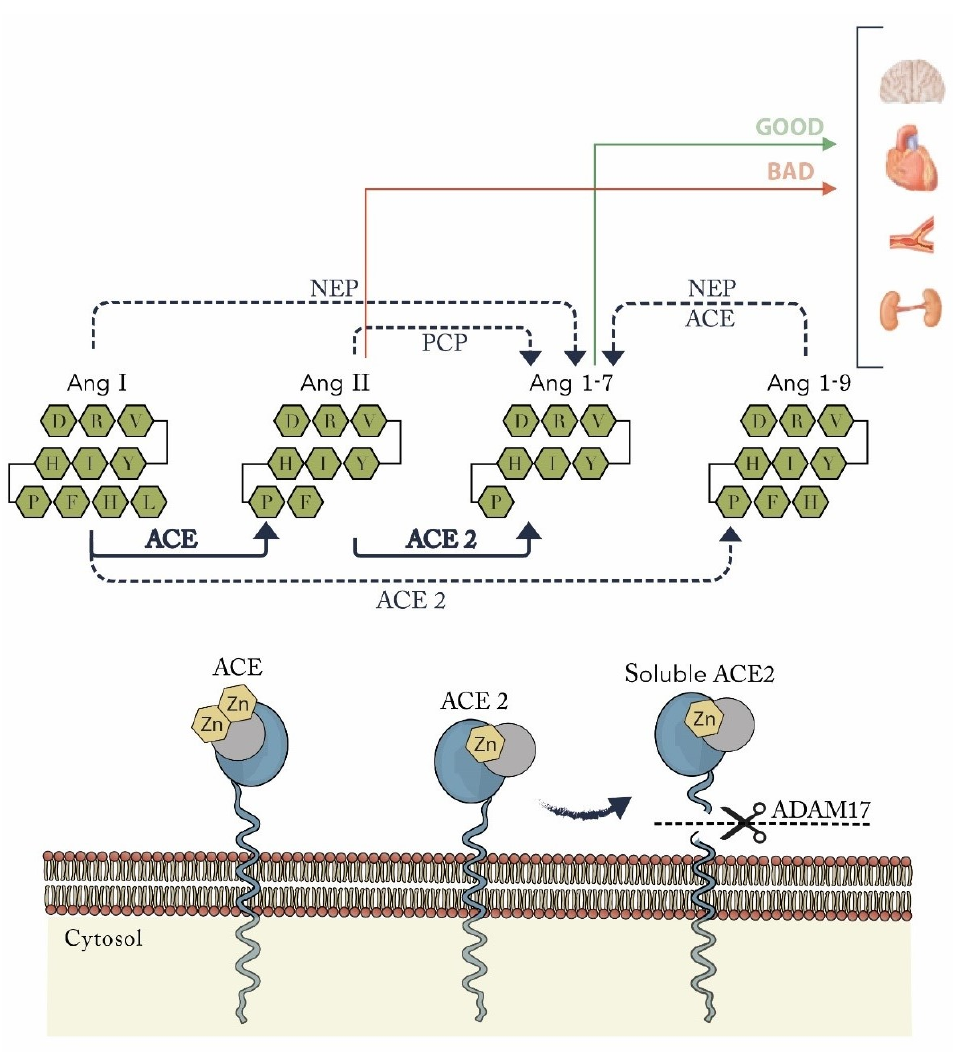
Figure 1. ACE2 pathway. ACE2 is >300 times more effective converting Ang II to Ang 1–7 than Ang I to Ang 1–9, in the presence of NEP or ACE, can convert Ang I and Ang 1–9 to Ang 1–7. ACE2 membrane-anchored protein at the catalytically active ectodomain undergoes shedding because of ADAM17, forming a soluble form of ACE2. ACE = angiotensin-converting enzyme; ACE2 = angiotensin-converting enzyme 2; Ang = angiotensin; NEP = neprilysin; PCP = prolylcarboxypeptidase; ADAM17 = disintegrin and metalloproteinase domain-containing protein 17; Zn = metalloproteinase zinc-binding site.